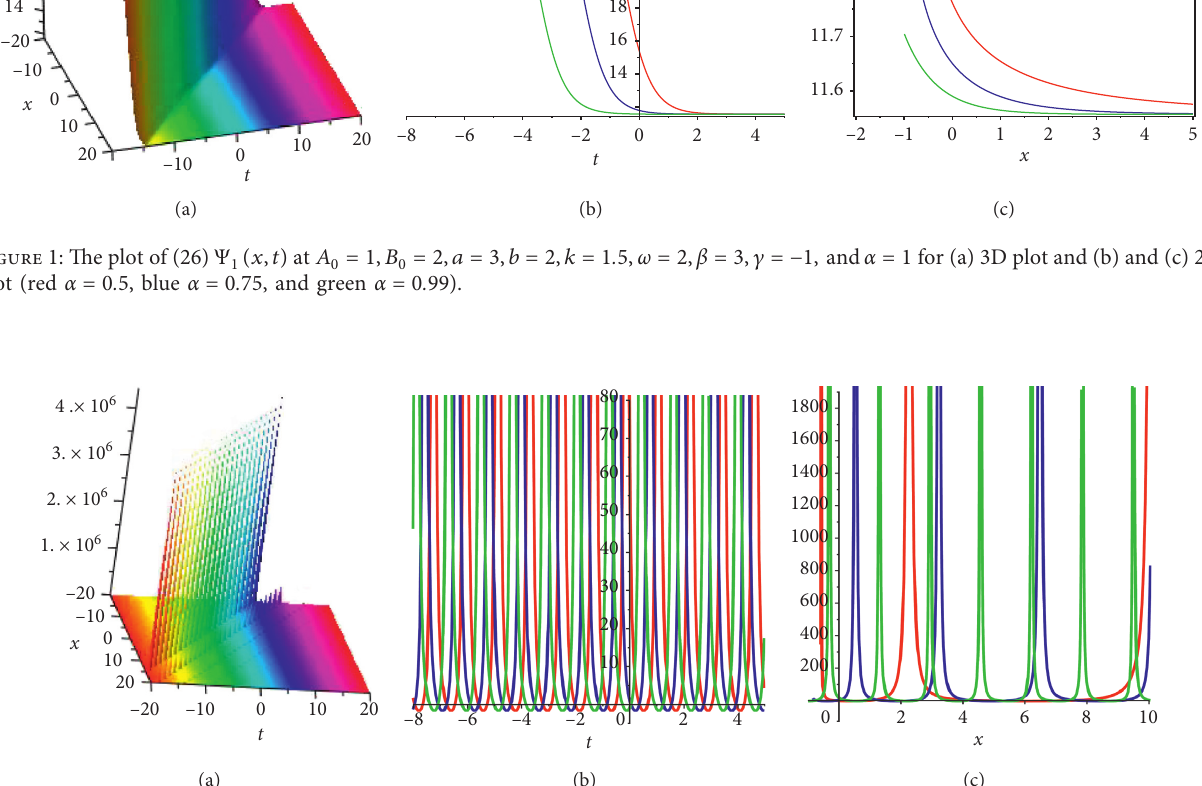
( x, t ) at A � 1 ,B � 2 ,a � 1 ,b � 2 ,k � 1 . 5 , ω � 2 , β � 3 , c � − 1 , and α � 1 for (a) 3D plot and (b) and (c) 2D 2 0 0